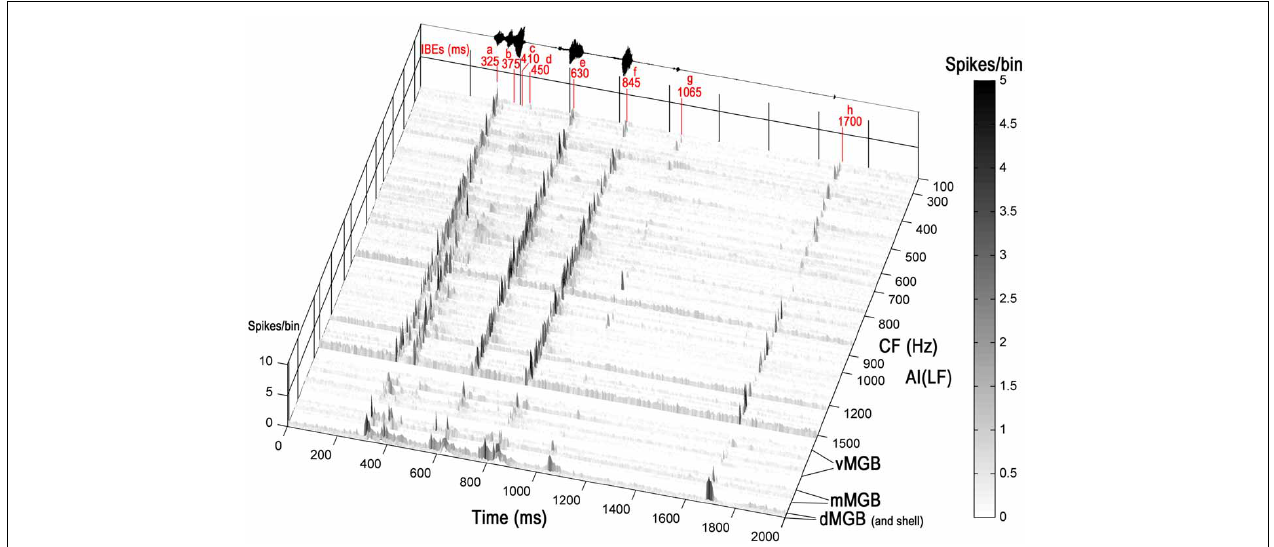
FIGURE 3 | Three-dimensional heat plot of the firing rate for all the units in the cortex and thalamus arranged in tonotopic order. Units from three divisions of the MGB are shown at the base of the figure and each division is separated by a white line. At the top of the plot there is a representation of the call waveform and the position of the eight